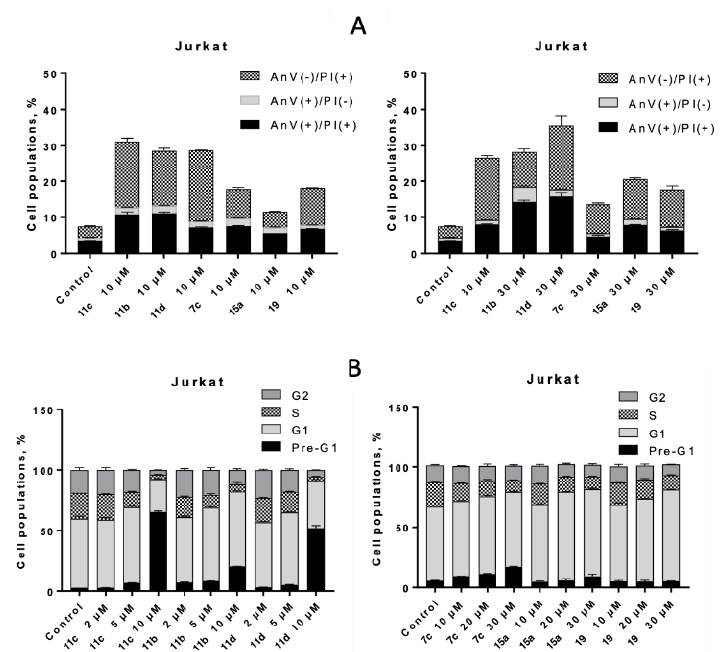
Figure 7. Cell cycle arrest and cell death induction by dual CK2-HDAC inhibitors. ( A ) the impact of the indicated compound doses on the distribution of Jurkat T-leukemia cells in the di ff erent phases of the cell cycle was determined by FACS of propidium iodide-stained cells after 24 h of continuous exposure. ( B ) evaluation of the impact of selected dual CK2-HDAC inhibitors (10 µ M and 30 µ M, 24 h) on phosphatidylserine externalization in Jurkat T-leukemia cells was determined by FACS, using FITC-labeled annexin V and PI staining. One of three experiments delivering comparable data is shown.